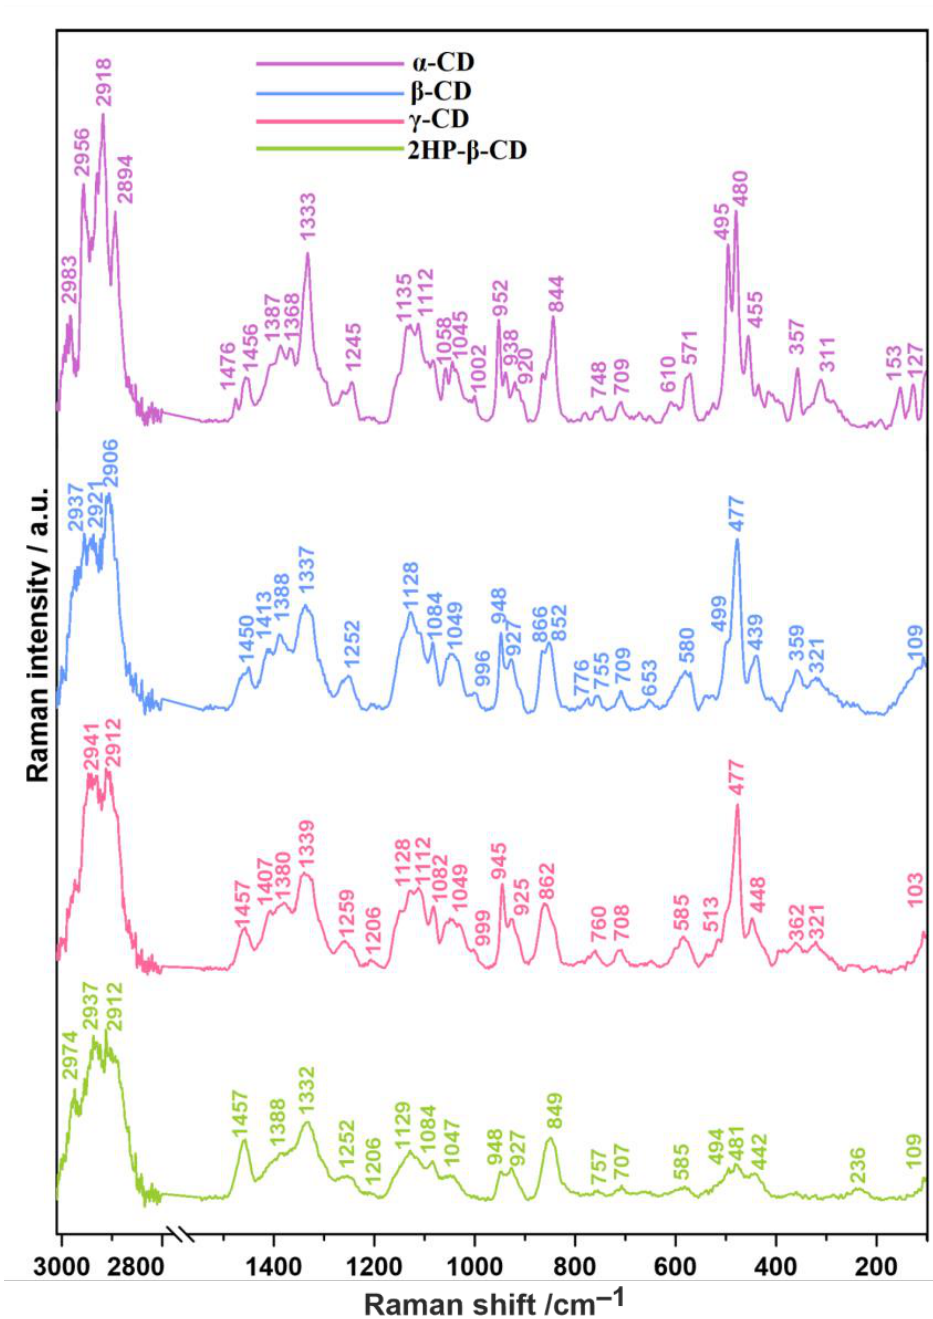
Figure 3. The Raman spectra of pure α-, β-, γ- and 2HP-β-CDs.